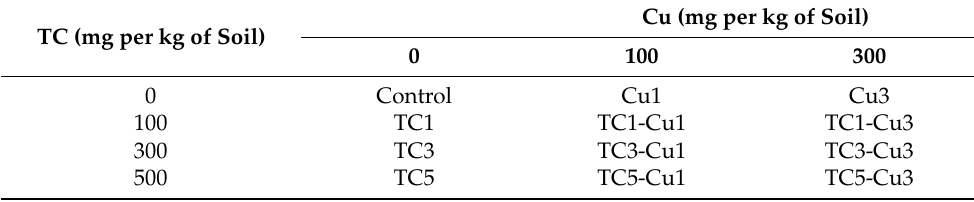
Table 2. Design of experimental treatment